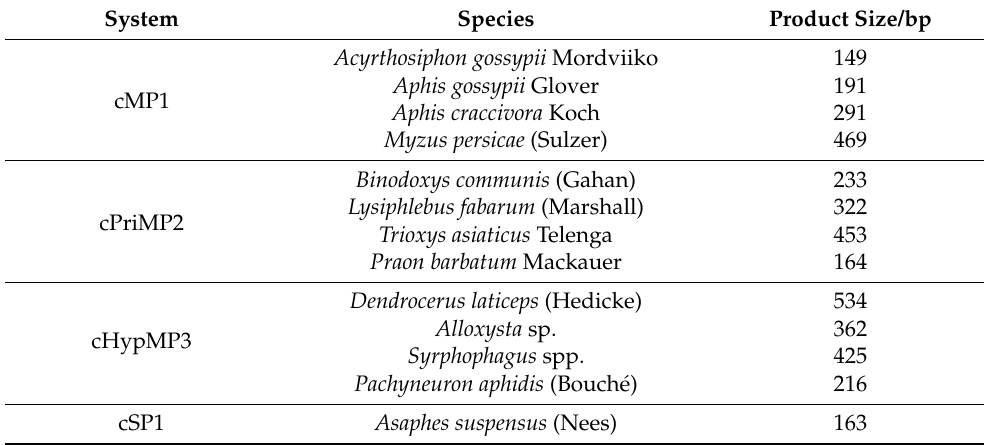
Table 1. Amplified DNA fragment sizes of aphids, primary parasitoids and